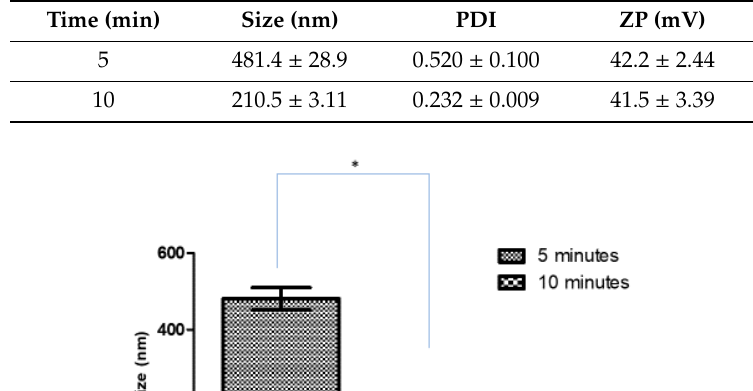
Table 2. E ff ects of sonication time on CSNPs loaded with 5 mg of Ag-FSE.